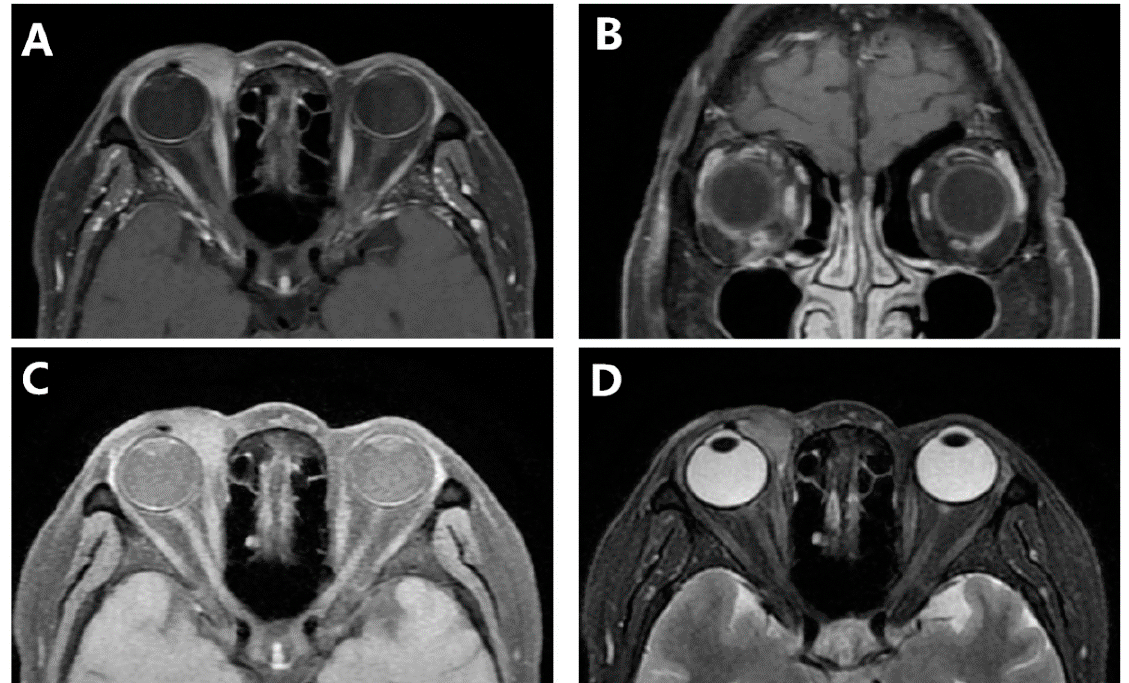
Figure 3. An MRI scan of the orbits showed a mass of irregular shape that appeared isointense on TI-weighted sequences located in the right medial orbital. ( A ) Horizontal view of contrast-enhanced TI-weighted fat-depressed sequences. ( B ) Coronal view on contrast-enhanced TI-weighted sequences. ( C ) Horizontal view of TI-weighted fat-depressed sequences. ( D ) Horizontal view of T2-weighted fat-depressed sequences.